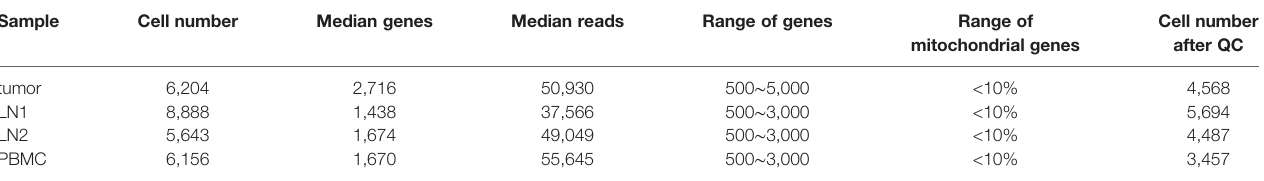
TABLE 1 | Details for each sample (The “ Range of genes ” and “ Range of Mitochondrial genes ” were the parameters of quality control).